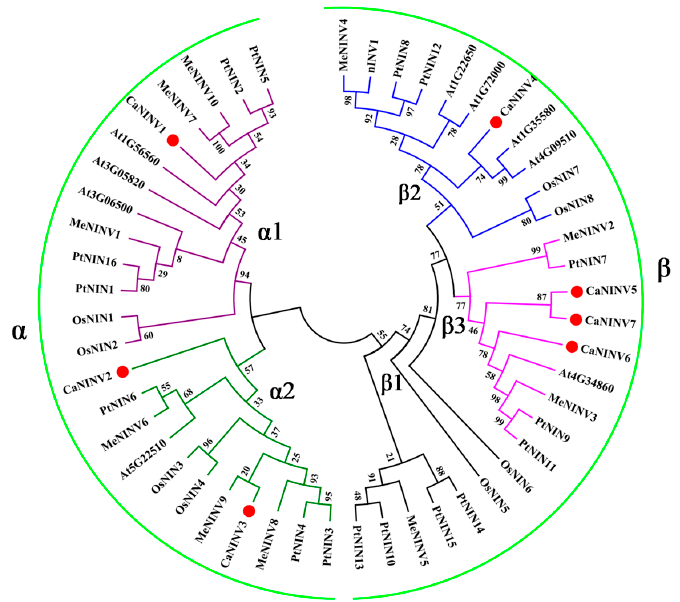
Figure 2. Phylogenetic analysis of alkaline/neutral invertase (NINV) proteins from C. annuum , M. esculenta , P. trichocarpa , A. thaliana , and O. sativa . The phylogenetic tree was constructed by Neighbor-Joining method (1000 bootstrap replicates) using Molecular Evolutionary Genetics Analysis 7.0 software. Red dots indicate the NINVs from C. annuum .